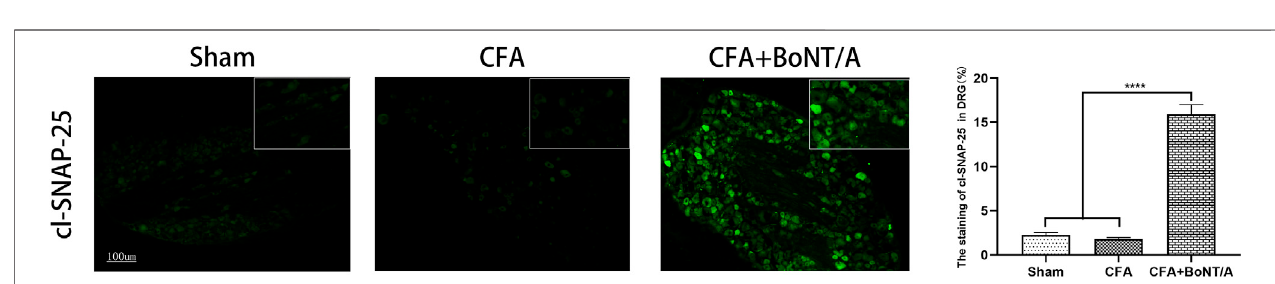
FIGURE 2 | Immuno fl uorescent staining of cl-SNAP-25 (BoNT/A markers) in DRG at 5 days after BoNT/A injection. Scale bar: 100 μ m. (**** p < 0.0001, CFA+BoNT/A group vs. Sham group; **** p < 0.0001, CFA+BoNT/A group vs. CFA group; p > 0.05, CFA group vs. Sham group).